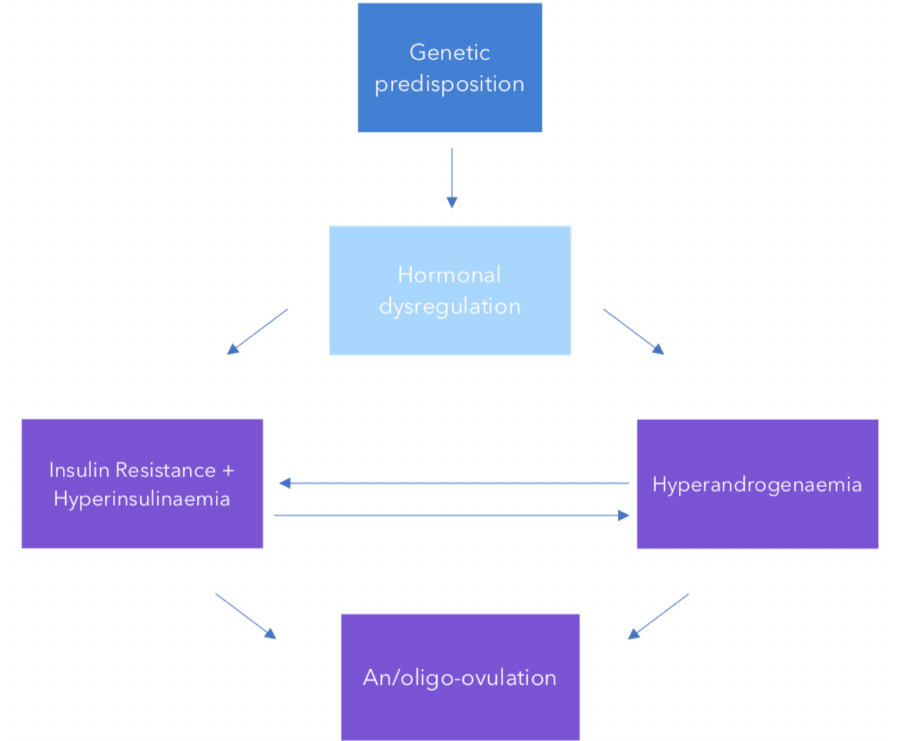
Figure 1. A schema of the pathogenesis and aetiology of polycystic ovary syndrome